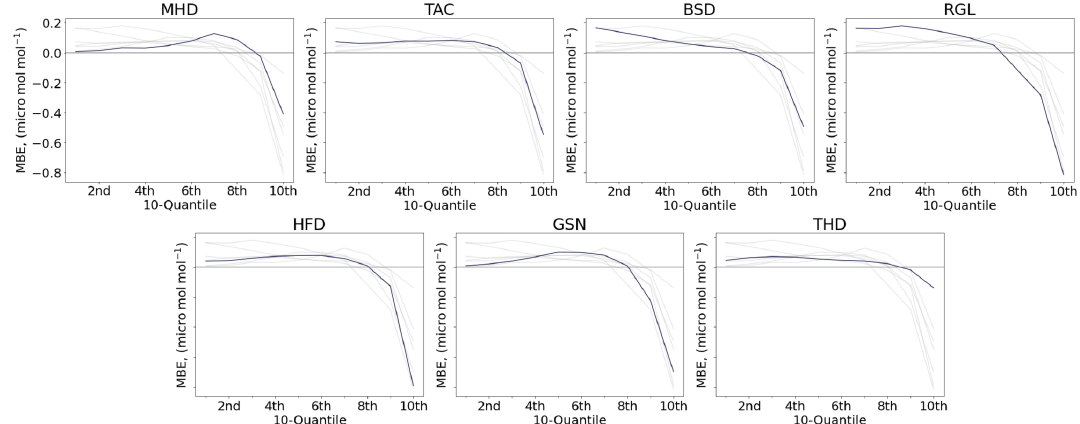
Figure 6. Mean bias error in the above-baseline mole fraction predictions for each of the 10 quantiles of the true data, across sites for 2016. An MBE above 0 indicates overprediction while an MBE below 0 indicates